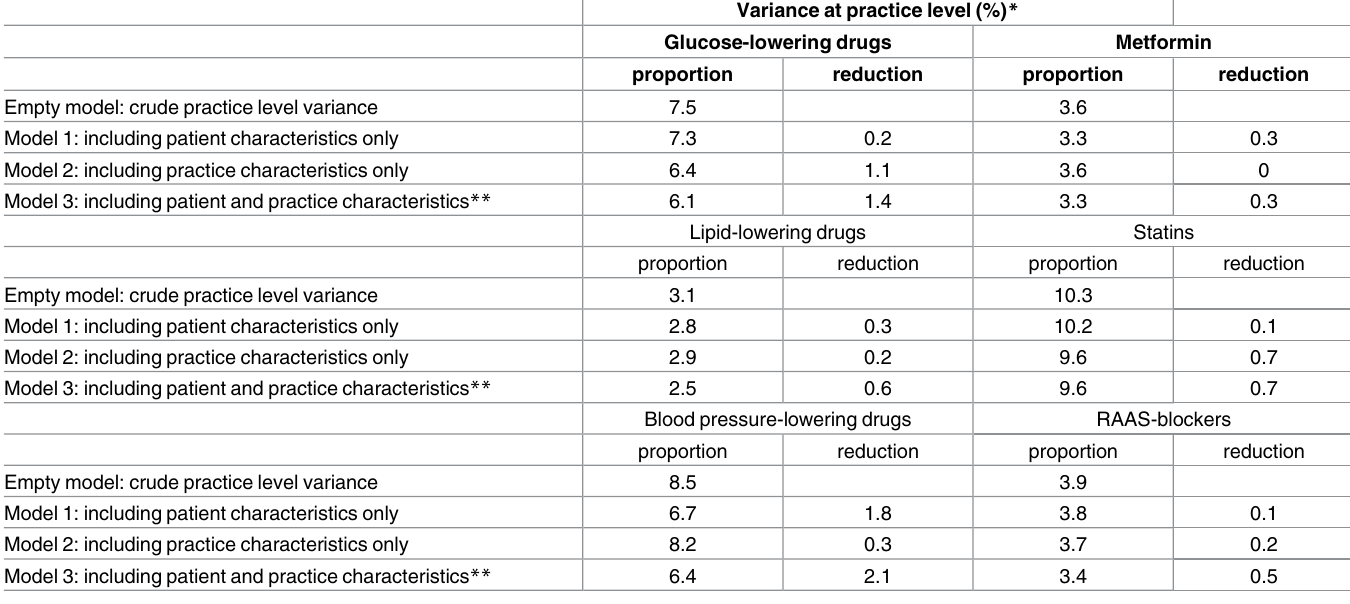
Table 3. Proportion and reduction of variancein treatment attributed to practice